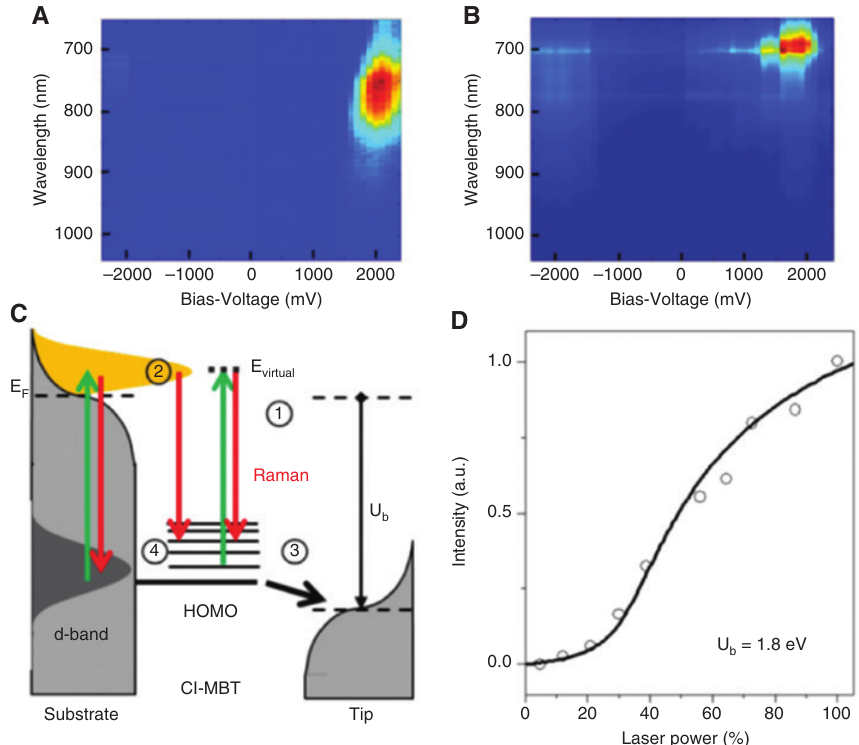
Figure 9: Superluminescence from a laser pumped molecular tunneling junction. (A) Electroluminescence spectra excited by inelastic tunneling without laser illumination as a function of the bias voltage. (B) Spectra from the tunneling junction excited at λ = 632.8 nm as a function of the bias voltage. (C) Schematic energy level diagram of the gap/molecule hybrid system in a laser-illuminated tunneling junction with (1) Raman scattering of the molecule, (2) hot electron generation, (3) HOMO depletion by hole injection and (4) stimulated emission. (D) Normalized experimental data (open circles) and calculated total emission (solid line) as a function of the incident laser power for fixed bias voltage 1.8 eV revealing a nonlinear increase, taken with permission from